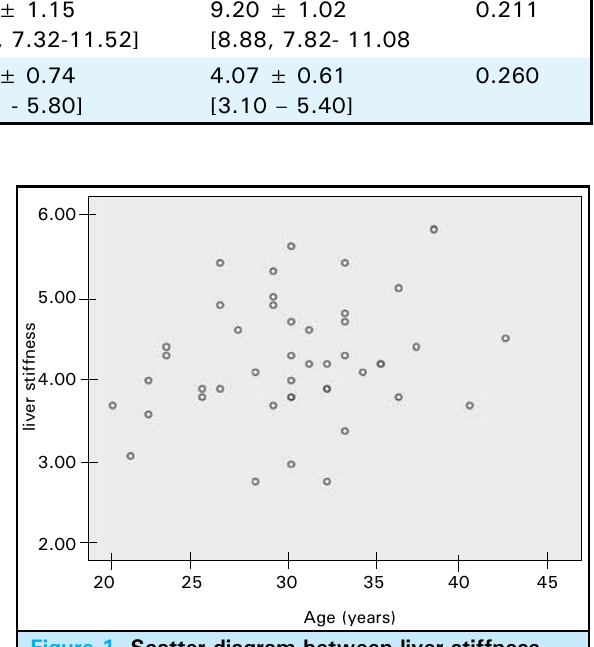
Figure 1. Scatter diagram between liver stiffness and age of the study